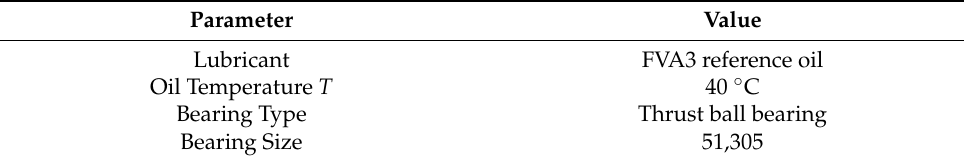
Table 2. Constant